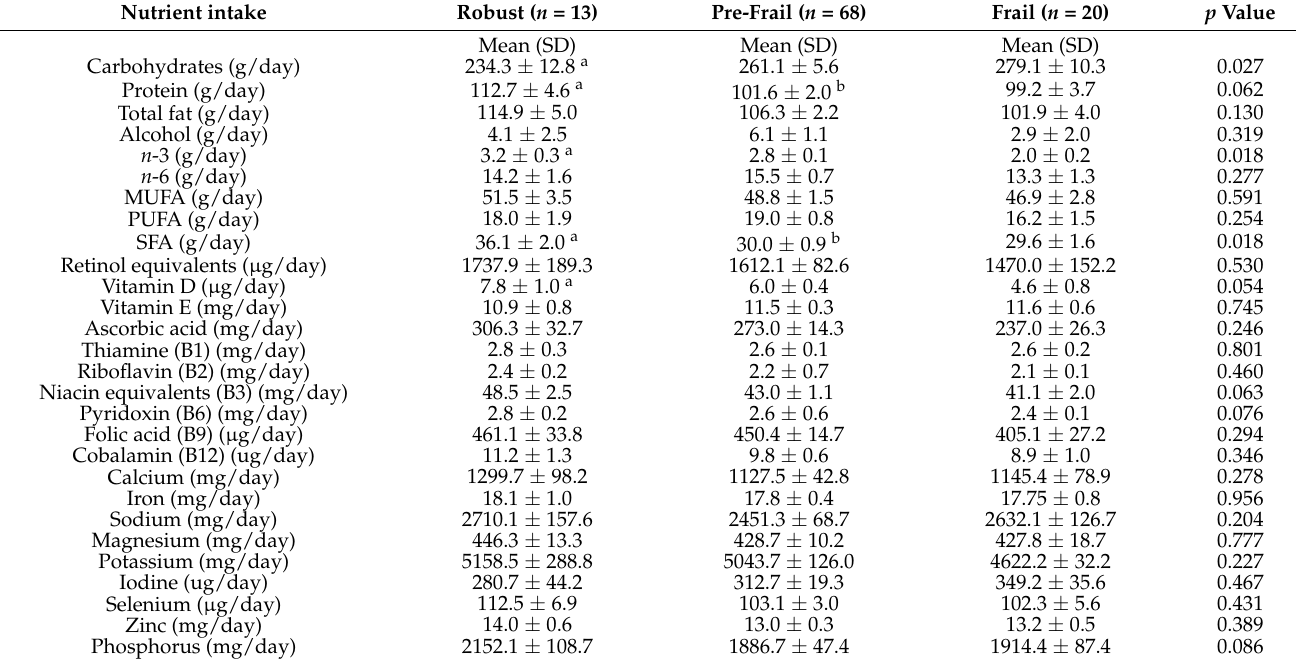
Table 4. Differences between SPPB groups in nutrients adjusted by energy intake. Nutrient